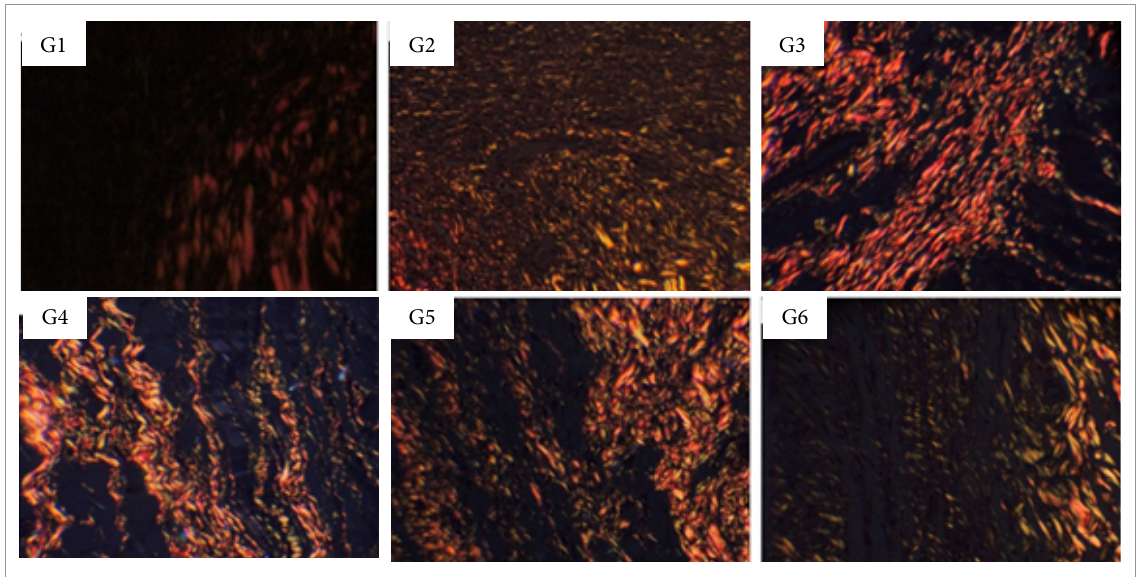
Figure 12 - Collagen fibers deposition in partial thickness burn wounds experimentally induced in Wistar rats 30 days after the injury induction (DAI). Collagen fibers type I are shown in red and type III in green. Stain Picrosirius red. Augmentation: 20x scale in μ